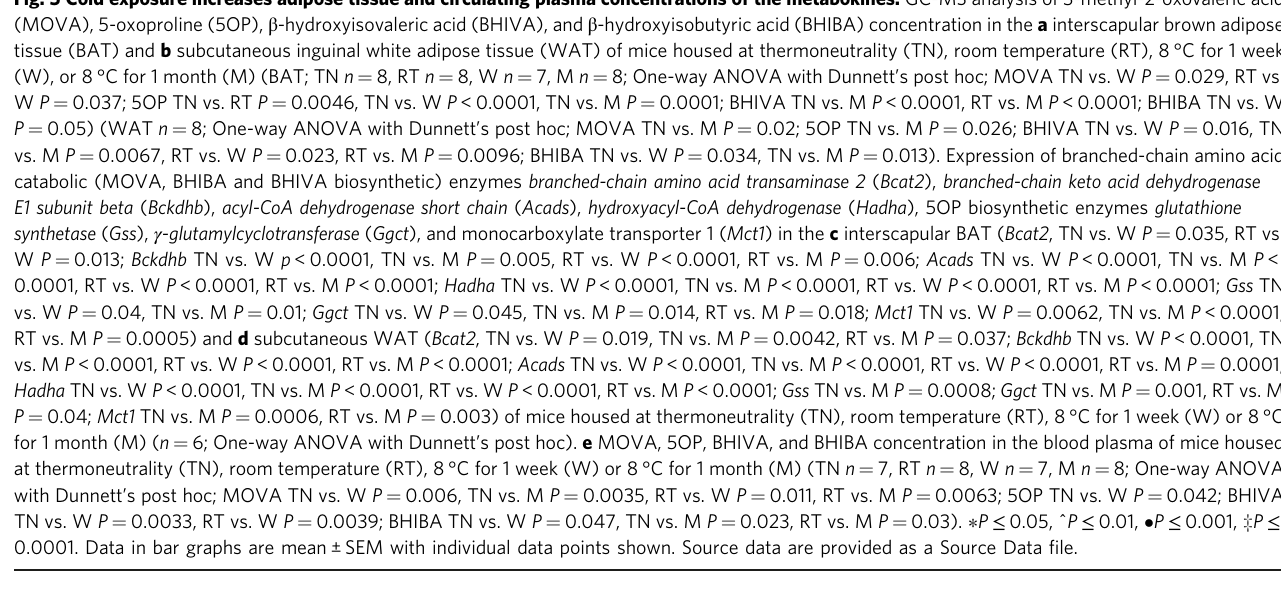
Fig. 5 Cold exposure increases adipose tissue and circulating plasma concentrations of the metabokines. GC-MS analysis of 3-methyl-2-oxovaleric acid (MOVA), 5-oxoproline (5OP), β -hydroxyisovaleric acid (BHIVA), and β -hydroxyisobutyric acid (BHIBA) concentration in the a interscapular brown adipose tissue (BAT) and b subcutaneous inguinal white adipose tissue (WAT) of mice housed at thermoneutrality (TN), room temperature (RT), 8 °C for 1 week (W), or 8 °C for 1 month (M) (BAT; TN n = 8, RT n = 8, W n = 7, M n = 8; One-way ANOVA with Dunnett ’ s post hoc; MOVA TN vs. W P = 0.029, RT